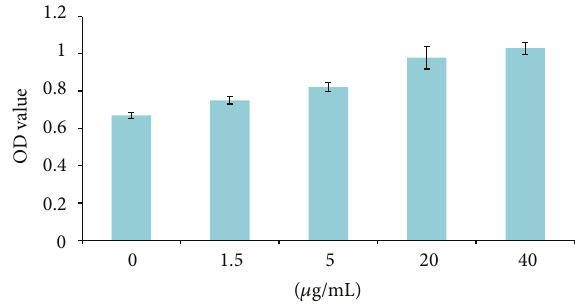
Figure 6: rBmBras2 effects on PLC proliferation